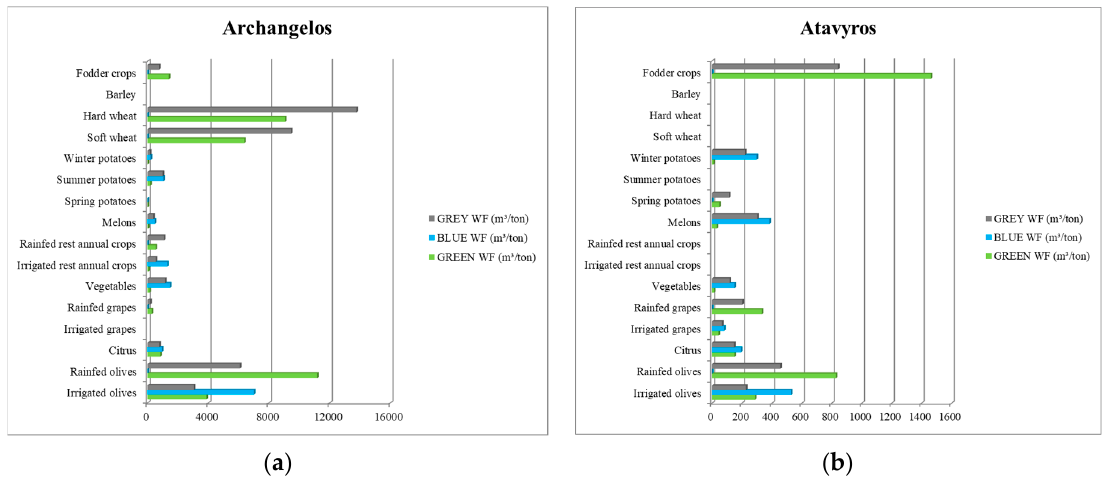
Figure 2. Blue, green, and gray WF (m 3 t − 1 ) for 2013 of ( a ) Archangelos MU and ( b ) Atavyros MU.